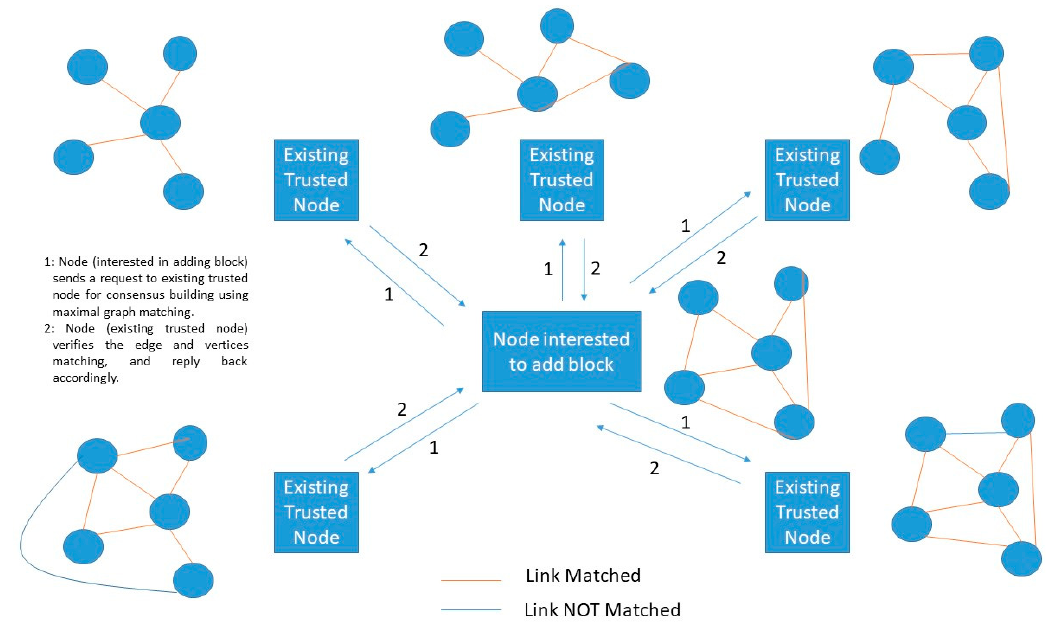
Figure 6. Proposed single player maximal graph (SPMG) PoG Consensus.